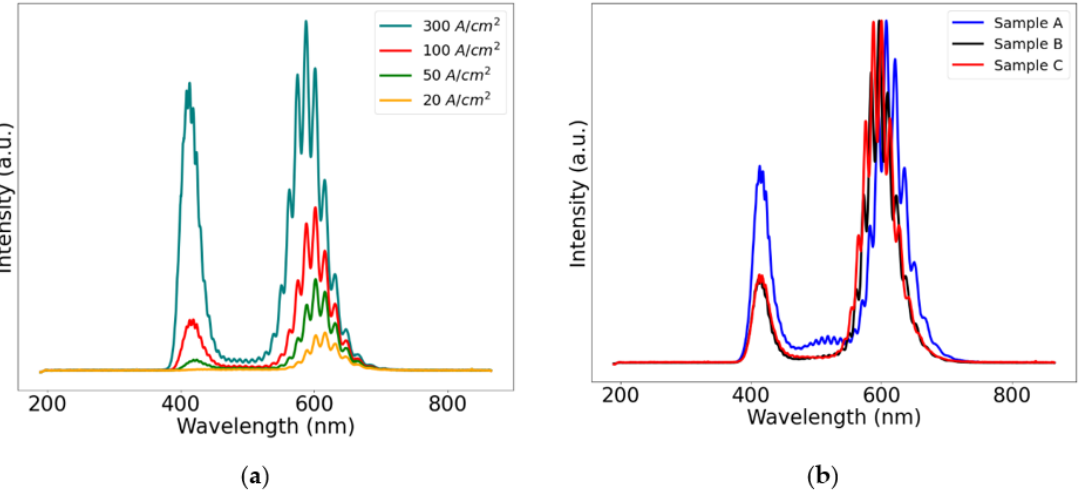
Figure 4. ( a ) Blue emission as a function of current density for an 80 µm LED from Sample C. The Fabry-Perot fringes are due to the EL spectra being measured on-chip with a Si substrate ( b ) EL spectra at 100 A/cm2 showing parasitic blue emission with red emission for samples A, B, and C.